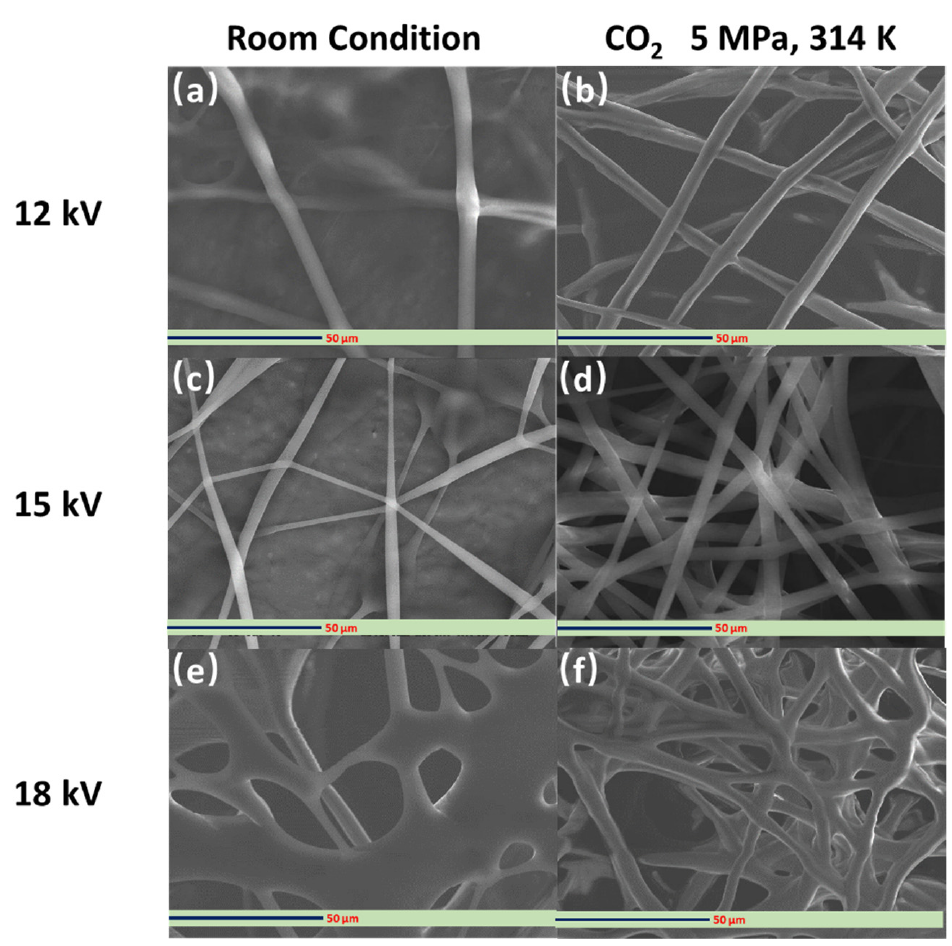
Figure 7. SEM images of PVP fibers fabricated from 10 wt% PVP solution with ( b , d , f ) and without ( a , c , e ) dense CO 2 at various applied voltage (12, 15, and 18 kV).